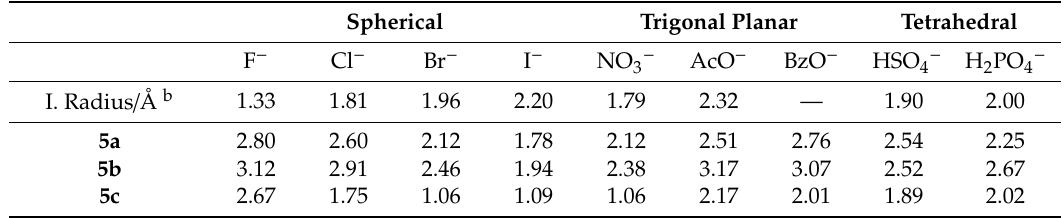
a Estimated error < 10%; b Data quoted in Marcus, I. Ion Properties ; Marcel Dekker: New York, pp.